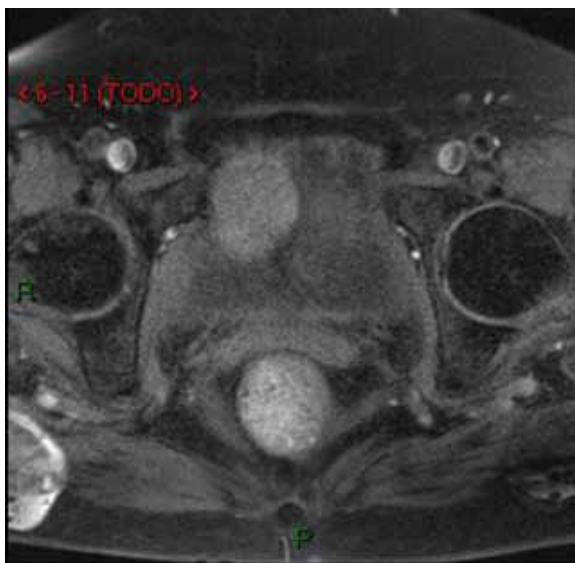
Figure 3 - Magnetic Resonance (MR) Imaging of the